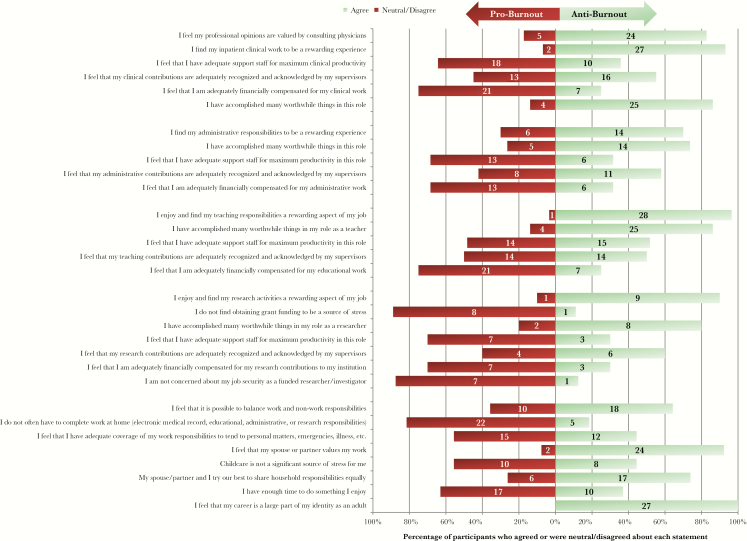
Results from selected infectious diseases-survey items.